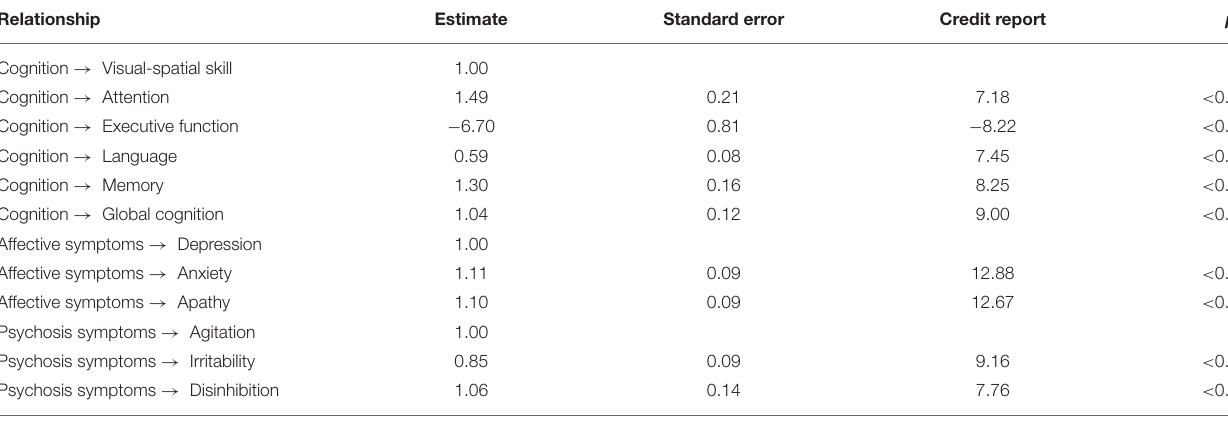
TABLE 4 | Unstandardized regression weights of the measurement model for the NPS group ( N = 168). Relationship Estimate Standard error Credit report